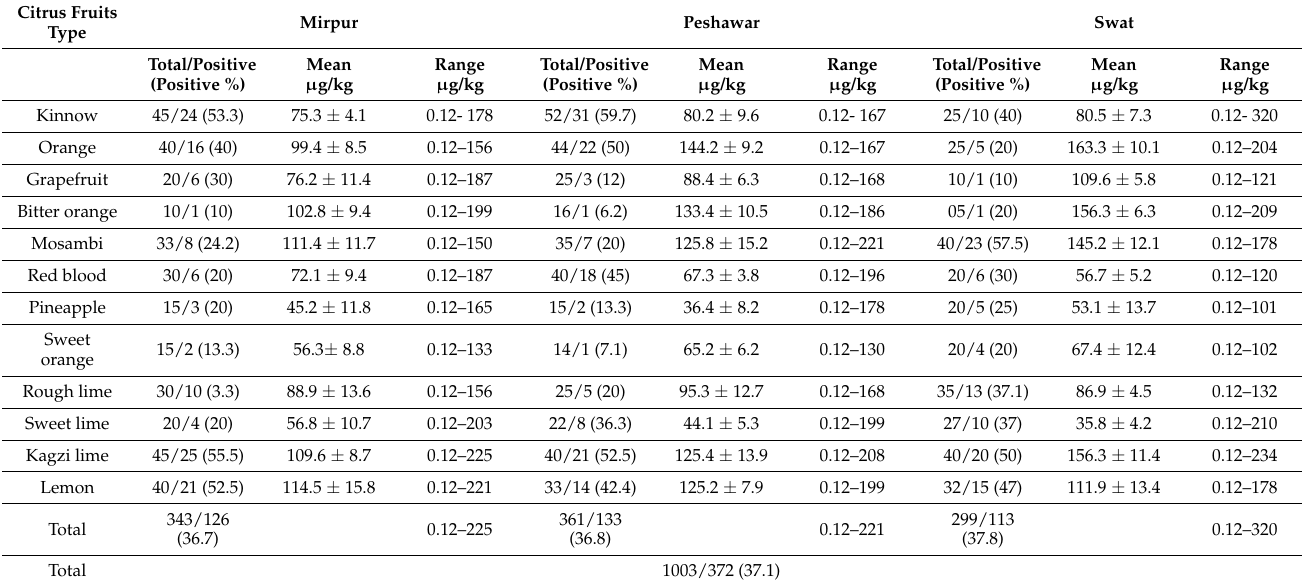
Table 3. Incidence levels of patulin in selected citrus fruit samples from northern areas of